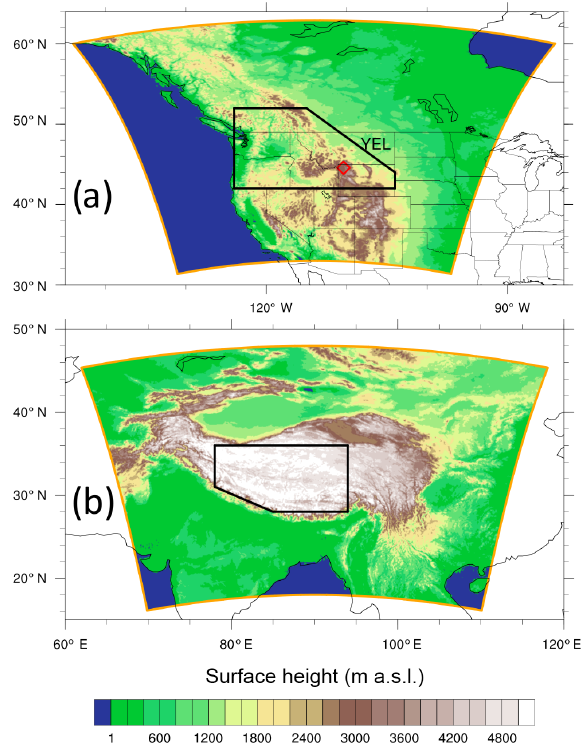
Figure 2. Height (ma.s.l.) of orography in COSMO and the domain of the simulations (orange boundaries) for the case studies (a) over western North America and (b) on the Tibetan Plateau. The red di- amond in panel (a) indicates the location of Yellowstone National Park (YEL, 44.6 ◦ N 110.4 ◦ W, 2468ma.s.l.). The black frames de- note “target regions” used in the tracer evaluation (see